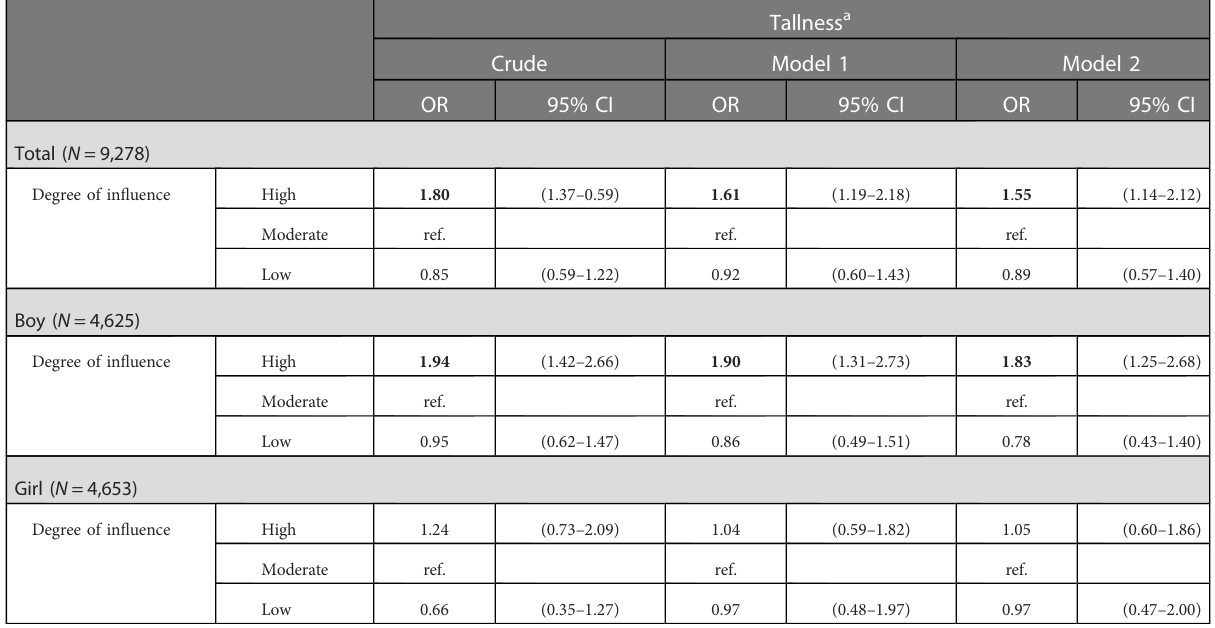
TABLE 3 The association between degree of in fl uence and